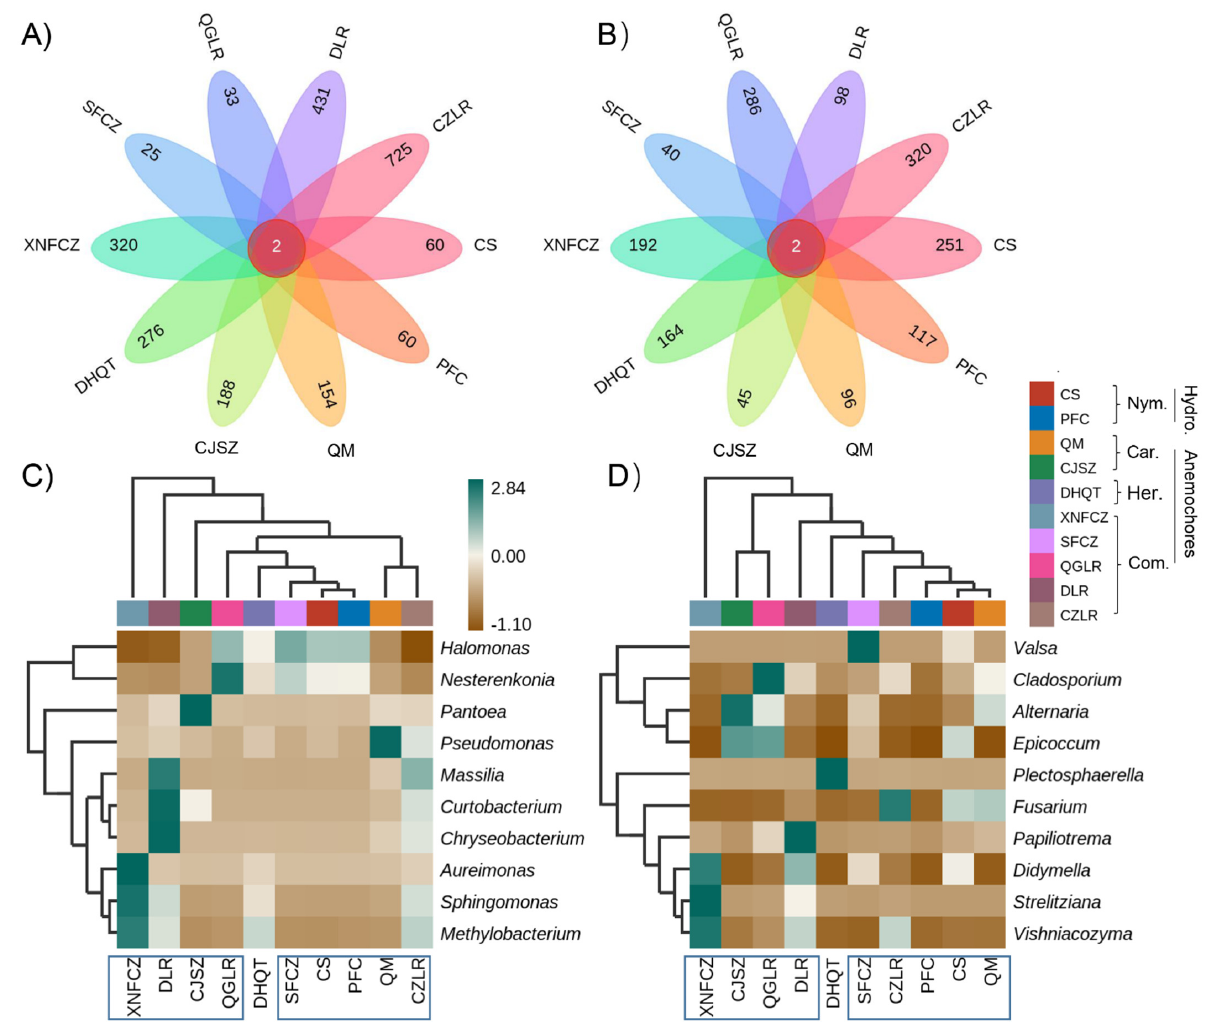
Figure 4. Petal diagram of the numbers of core and unique bacterial ( A ) and fungal ( B ) amplicon sequence variants (ASVs) and the double cluster heatmaps of the relative abundance of the top 10 bacterial ( C ) and fungal ( D ) genera within seeds of eight anemochores and two hydrochores. The horizontal and vertical clusters represent the groupings based on plant species and seed endo- phytes, respectively. Heatmap colors represent the averaged relative percentage of bacterial/fungal genera within each plant seed (n = 3). Color squares shifted towards green indicate higher abun- dance. The abbreviations behind the bracket indicate plant family name (Car, Caryophyllaceae; Com, Combretaceae; Her, Hernandiaceae; Nym, Nymphaeaceae) and their assigned dispersal mode (hydrochores/anemochores), including two hydrochoric herbs (CS, Euryale ferox ; PFC, Nuphar pumila ), two anemochoric herbs (QM, Dianthus superbus ; CJSZ, Dianthus repens ), three anemochoric vines (DHQT, Illigera grandiflora ; XNFCZ, Combretum griffithii ; SFCZ, Combretum wallichii ), and three tree species (QGLR, Terminalia myriocarpa ; DLR, Terminalia franchetii ; CZLR, Terminalia franchetii